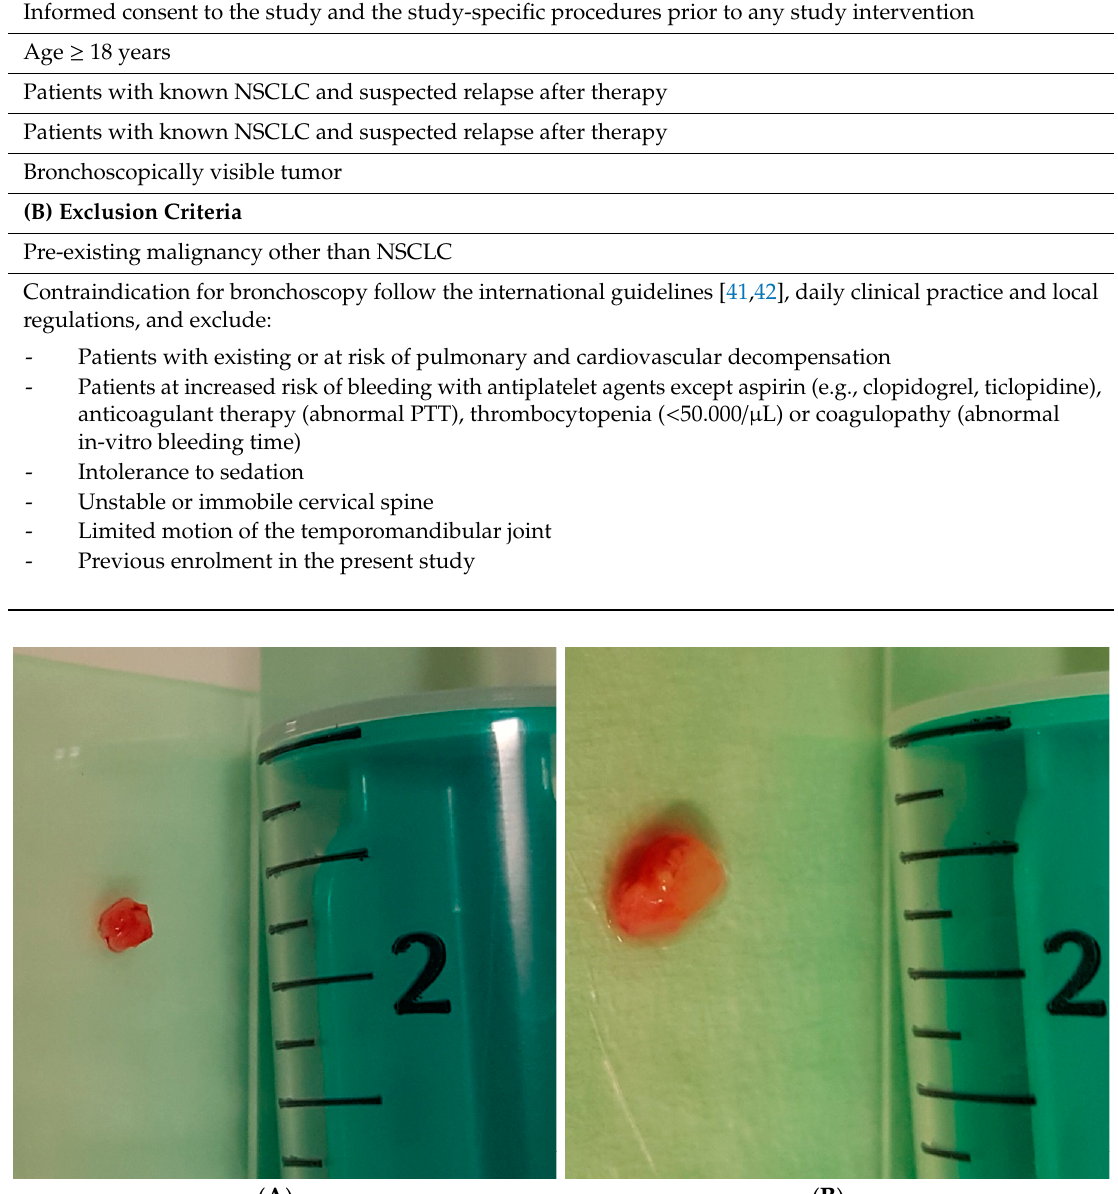
Table 1. ( A ) shows Inclusion criteria of the study; ( B ) shows Exclusion criteria of the study. (A) Inclusion Criteria